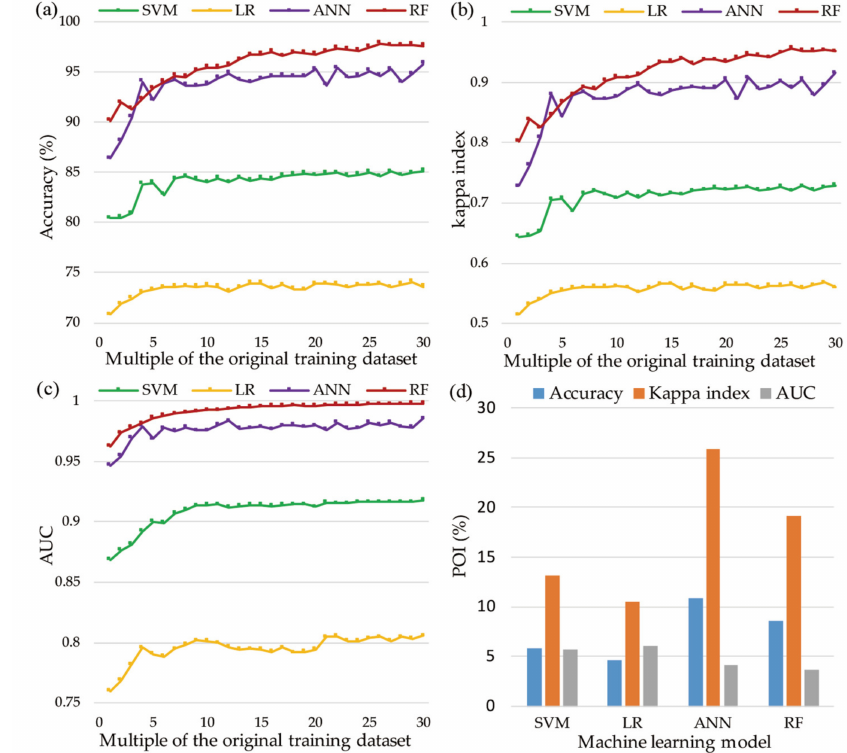
Figure 9. Fitting performances: ( a ) accuracy of each model with different training datasets; ( b ) kappa index of each model with different training datasets; ( c ) area under the curve (AUC) of each model with different training datasets; and ( d ) percentage of improvement (POI) of each model between the first and 30th training